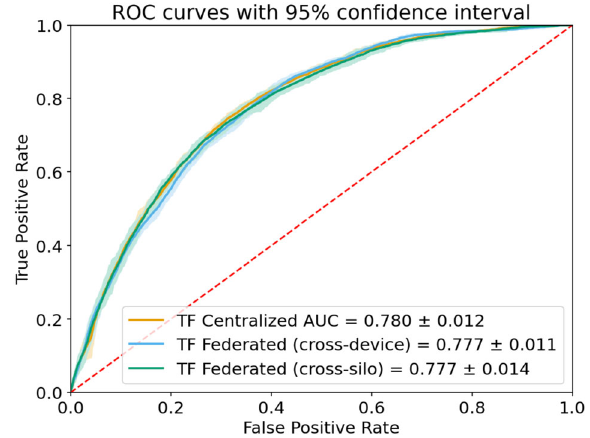
Fig. 2 Receiver operating characteristic curves for the three learning setups on MIMIC-III data predicting inpatient mortality. Shaded areas show 95% con fi dence